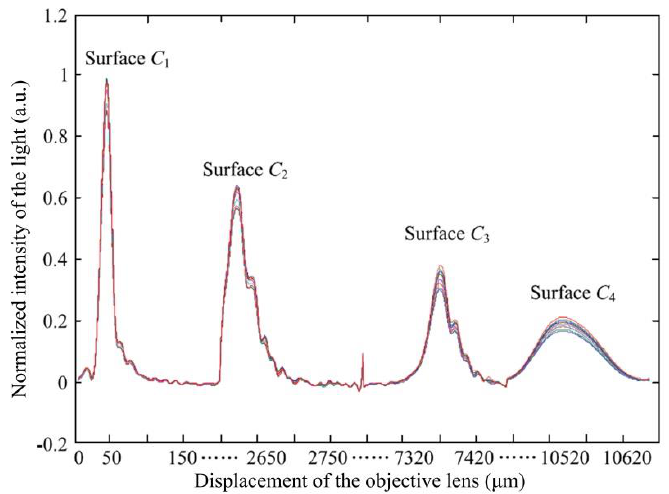
Figure 23. Experimental measuring results of two lenses. (Figure reproduced from Ref.